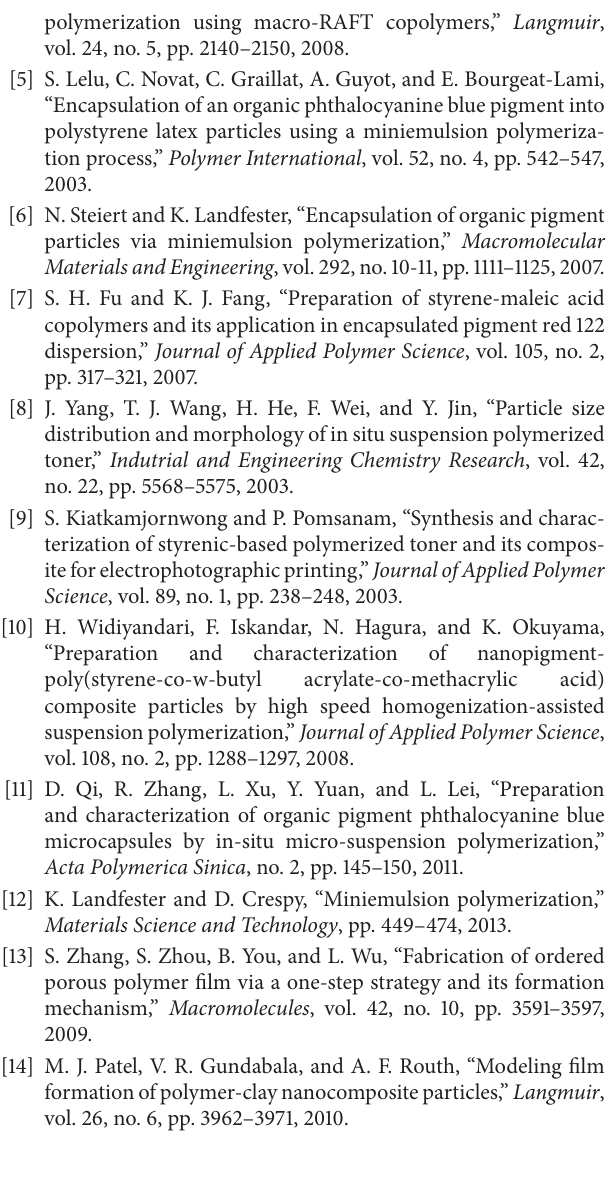
Table 1: The printing qualities of cotton fabrics using the nanocomposites latex and blended latex as printing paste. Printing paste form Blended latex P(BA+St) −